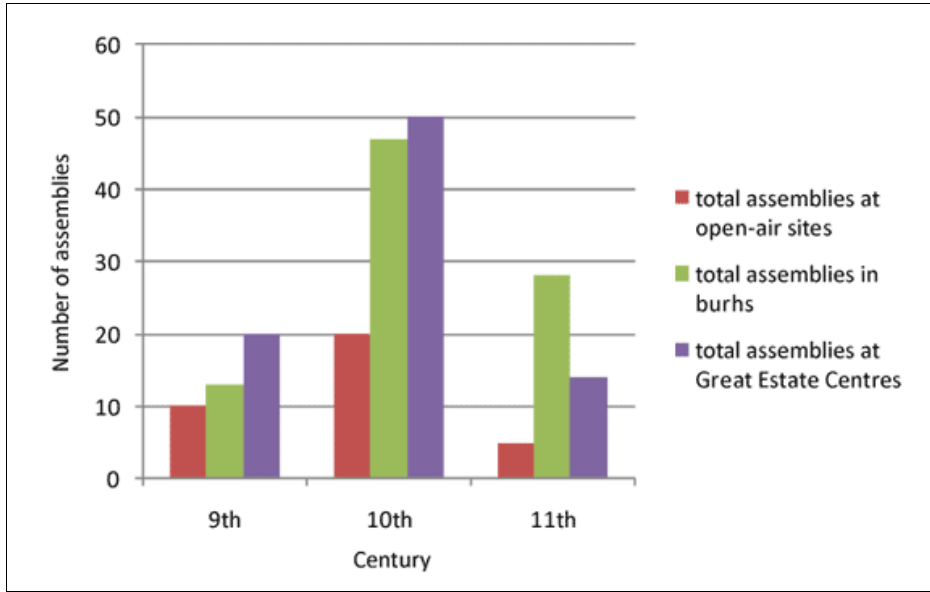
Fig. 5: The changing locations of the witangemot during the 9th, 10th and 11th